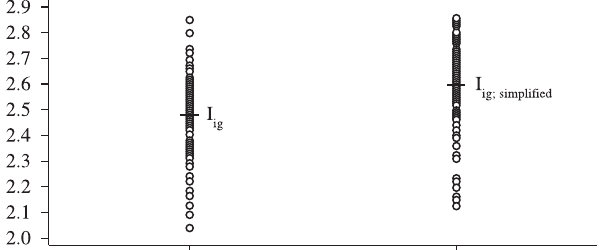
Figure 8. Populations of I